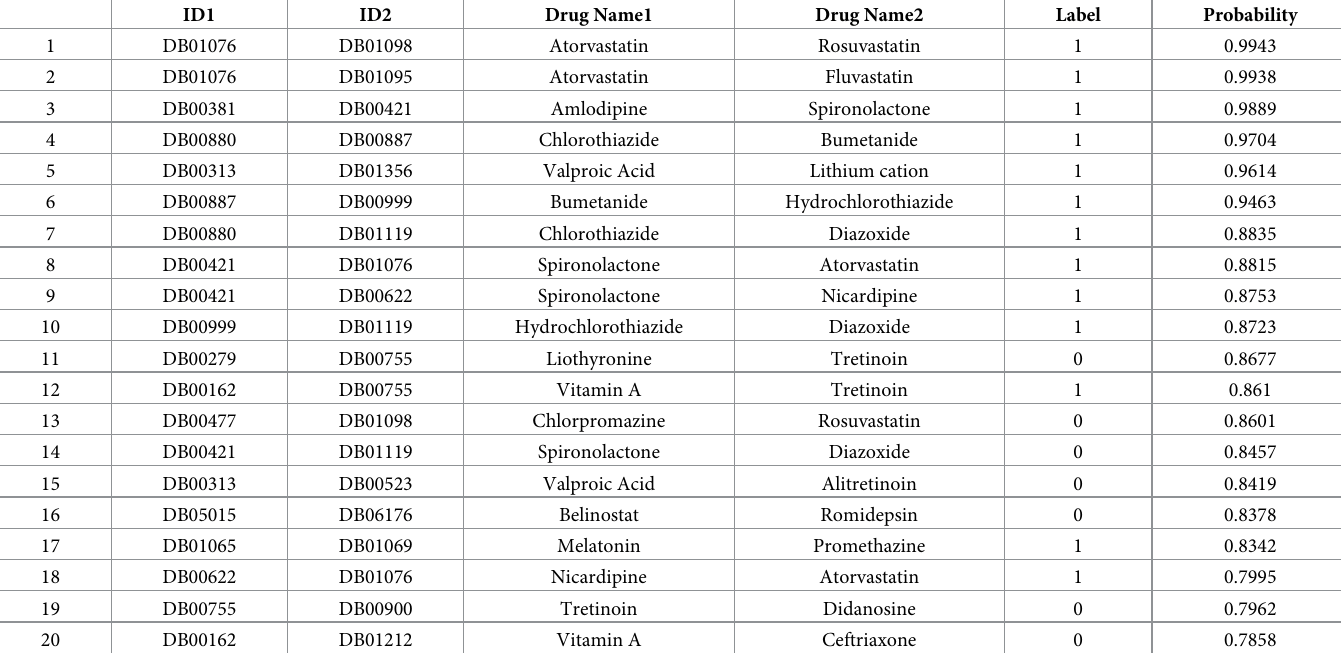
Table 1. Top 20 DDI predictions in the test